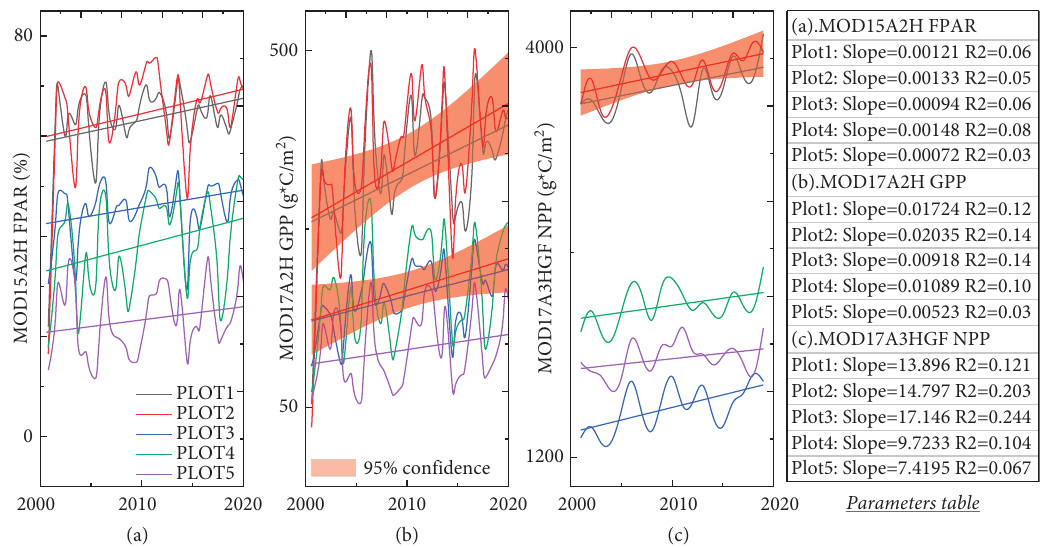
Figure 7: Biomass change trend of the swamp wetland on a plot scale. (a), (b), and (c) are the change trend of MOD15A2 FPAR (2000–2020), MOD17A2H GPP (2000–2020), and MOD17A3HGF NPP (2000–2020),